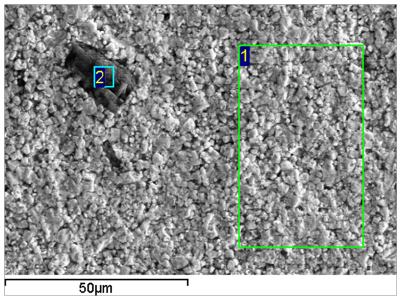
Figure 2. Scanning electron microscopy of the 8 t sample. Table 1. Elemental content of the areas in Figure